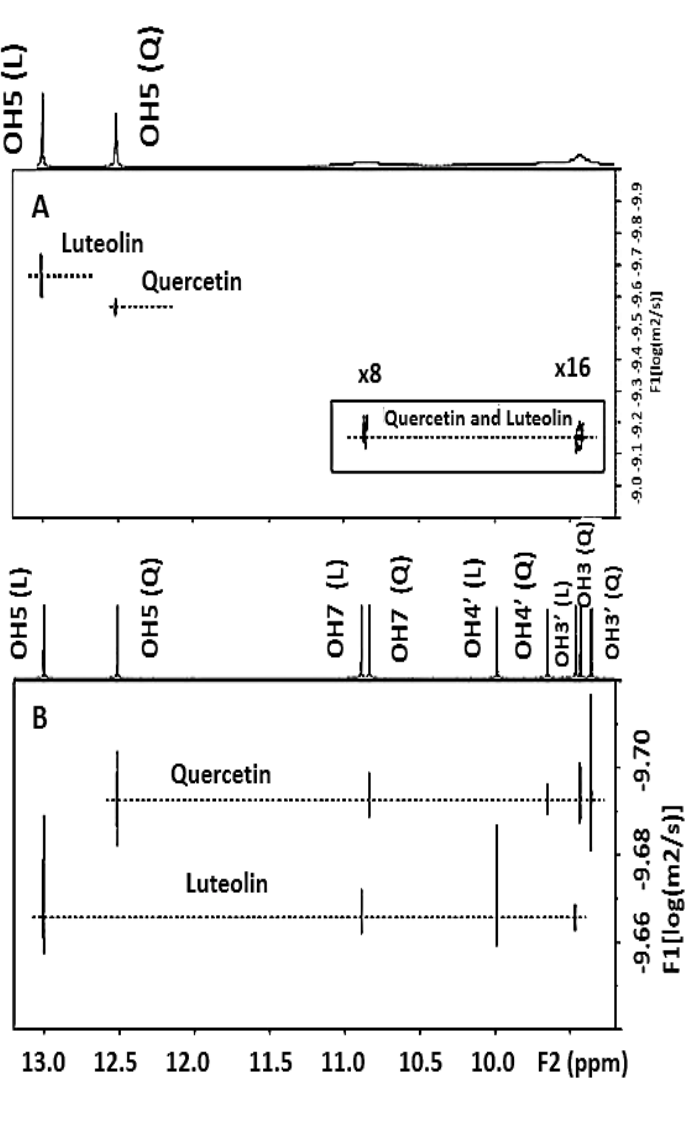
Figure 21. Fine-tuning of quercetin (Q) and luteolin (L) (Table 2) diffusion values. 500 MHz 1 H-NMR DOSY of a mixture of luteolin (3.7 mM) and quercetin (3.5 mM) in DMSO- d (289 K, Δ = 100 ms, δ = 4.8 ms, ns = 16, total experimental time 27 min). The 6 g insert indicates the hydroxyl protons at a lower contour level (×8 and ×16). ( A ) Without and ( B ) with the addition of 0.07 mM picric acid (molar ratio [picric acid]/[luteolin]~0.014 and [picric acid]/[quercetin] = 0.015). Reproduced with permission from [55].